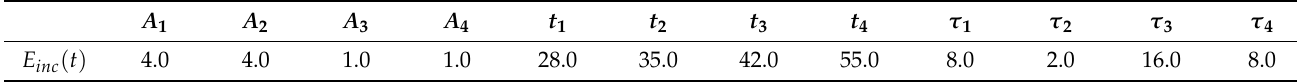
Table 1. Parameters of the artificial signal E inc ( t )